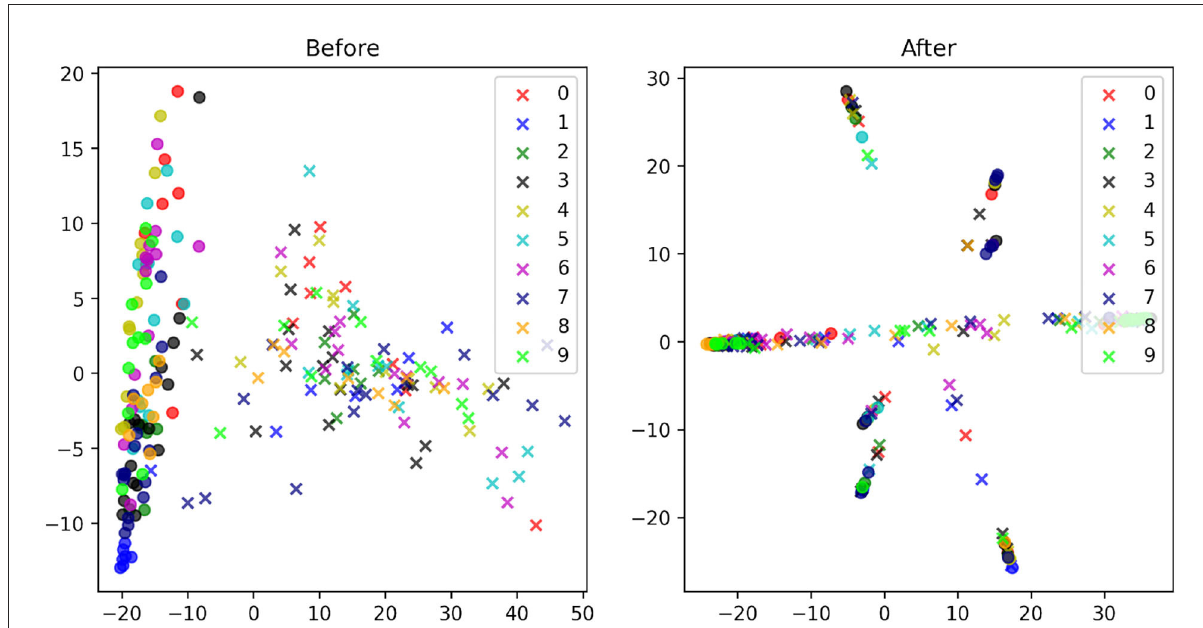
FIGURE7 The PCA plots of the MNIST (circles) and MNIST-M (crosses) images with the corresponding digits they represent given in a unique color before (left) and after (right) the proposed